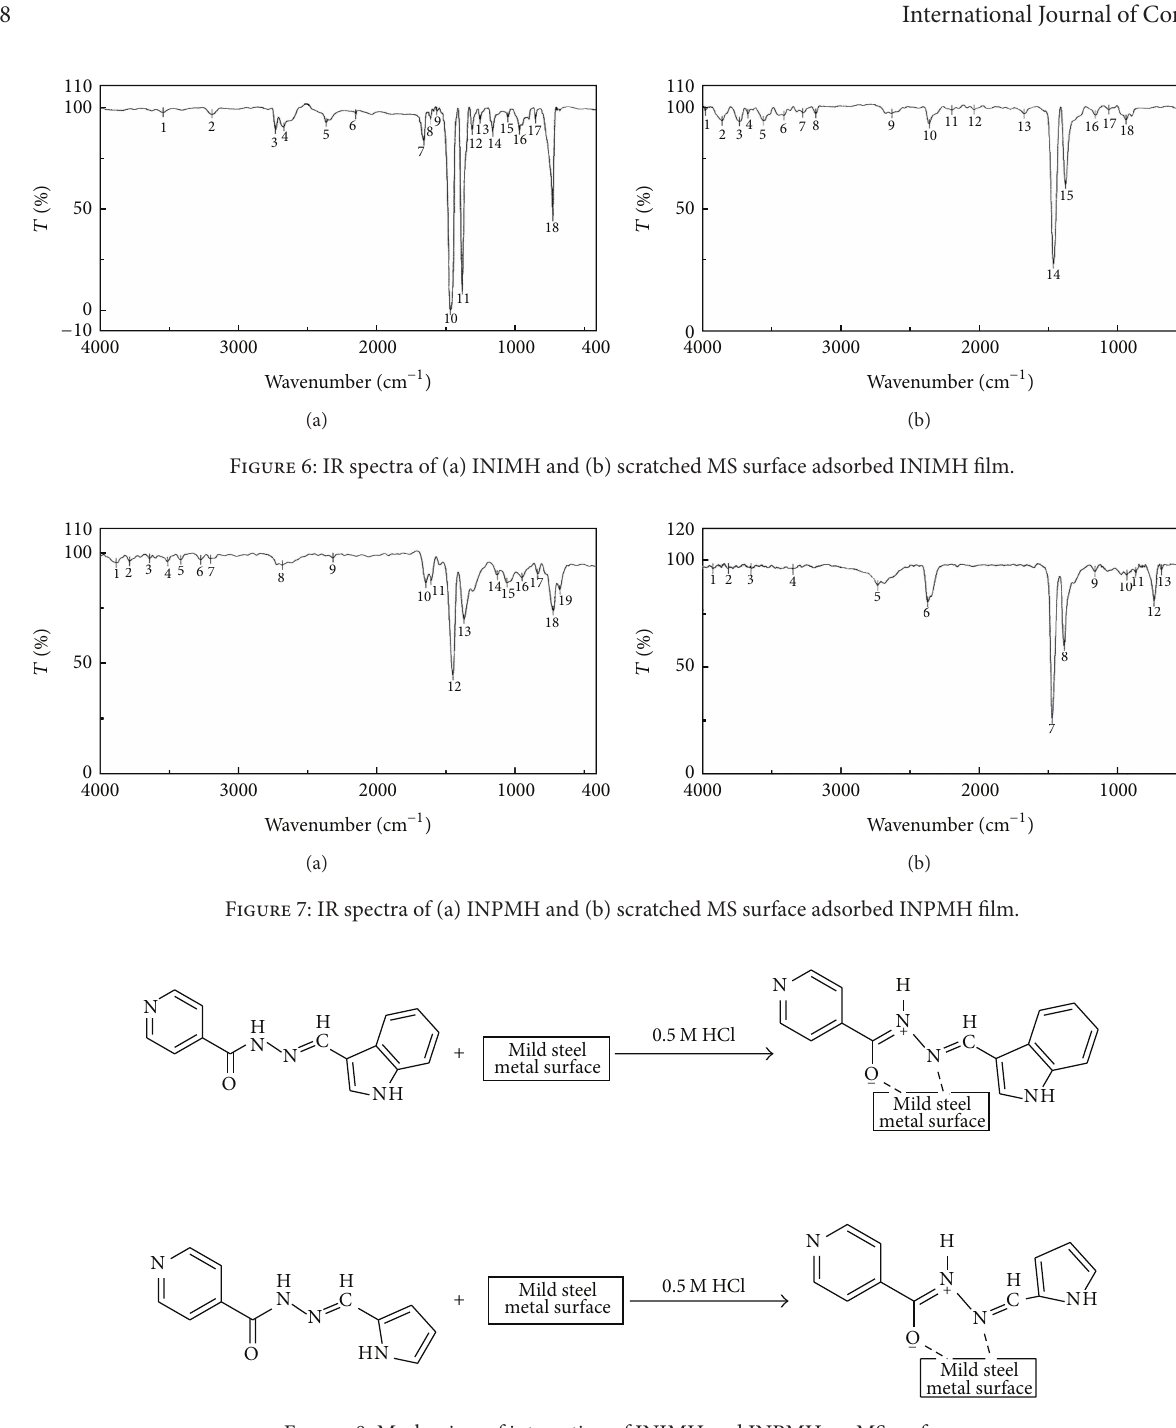
Figure 8: Mechanism of interaction of INIMH and INPMH on MS